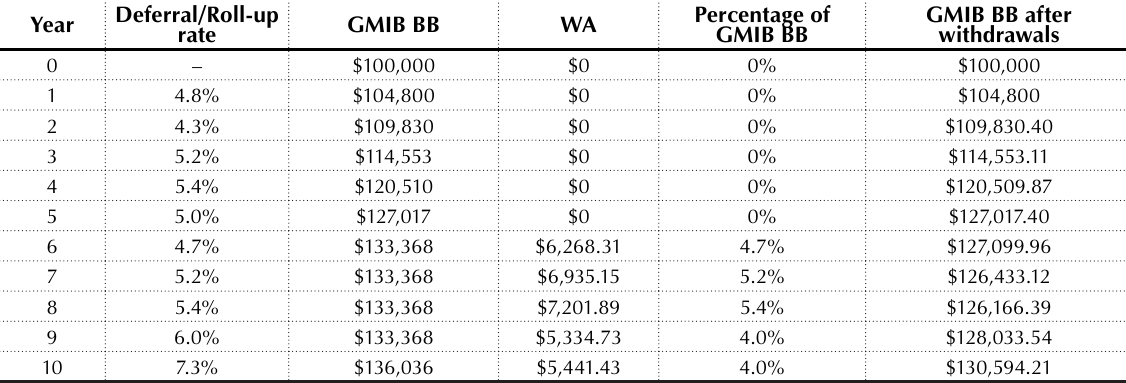
Table 1. GMIB benefit base evolution for an allocation of $100,000 with partial withdrawals that does not affect the value of the guaranteed account Deferral/Roll-up Year